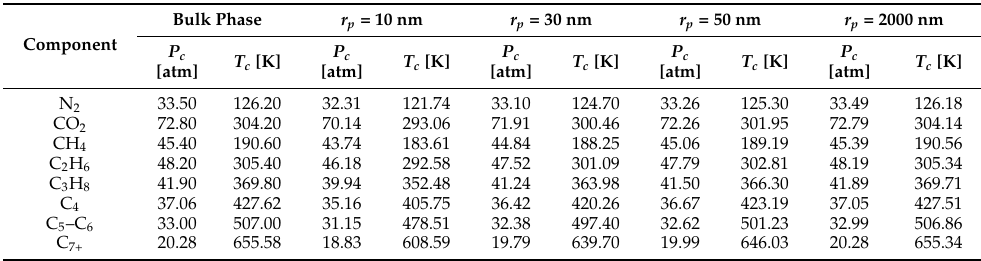
Table 3. Critical properties of the eight pseudocomponents corresponding to different pore radius in Duvernay volatile oil well.